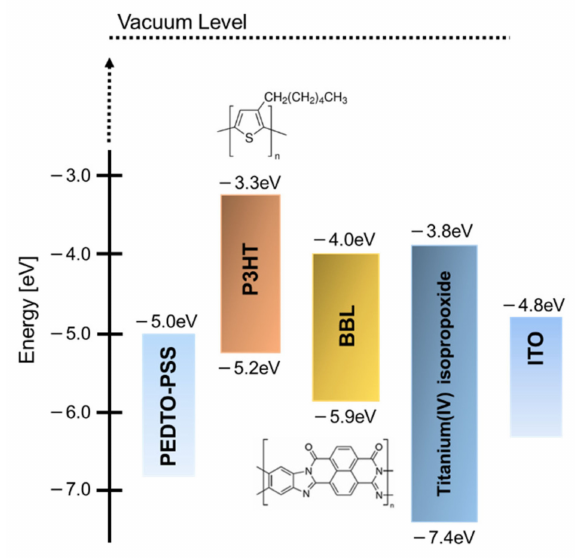
Figure 1. Materials and energy